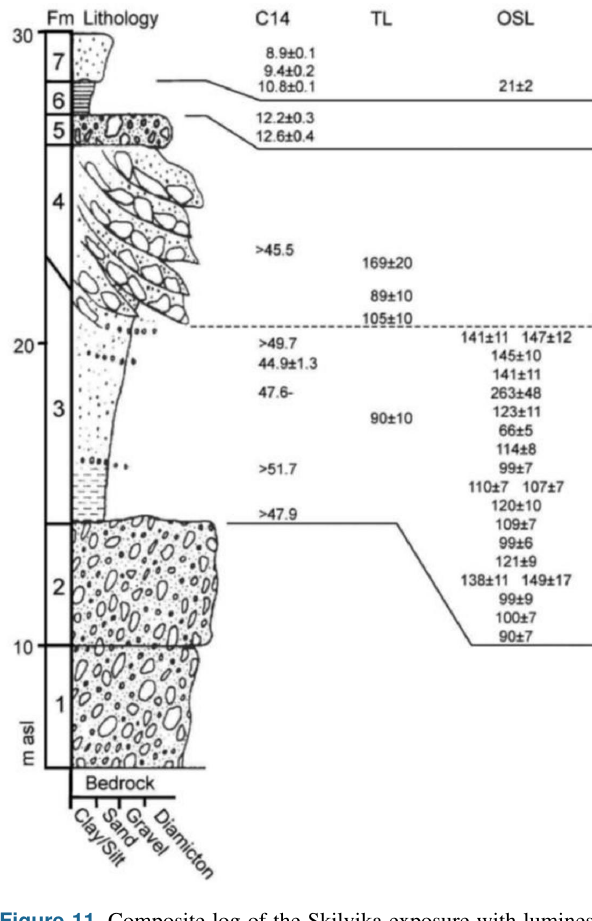
Figure 11. Composite log of the Skilvika exposure with lumines- cence (TL and OSL in ka) and radiocarbon ages (in cal.ka for ages > 40ka, uncalibrated for younger ages). Formations (Fm) 3 and 4 are the candidates for the LIG (from Alexanderson and Landvik, 2018).